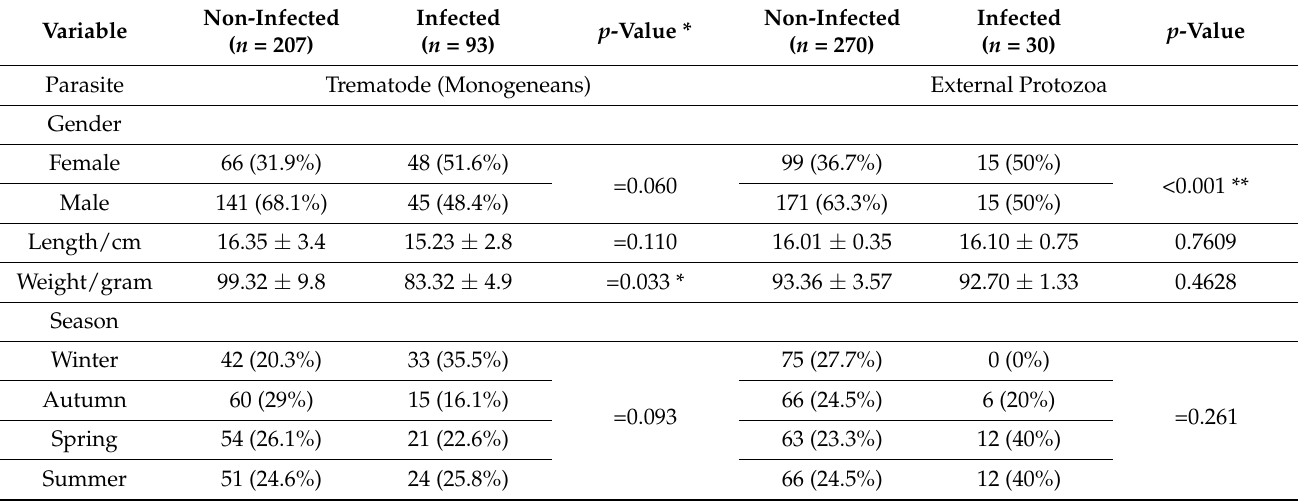
Table 3. Prevalence of ectoparasites in relation to sex, size and seasonal condition in Nile tilapia fish.